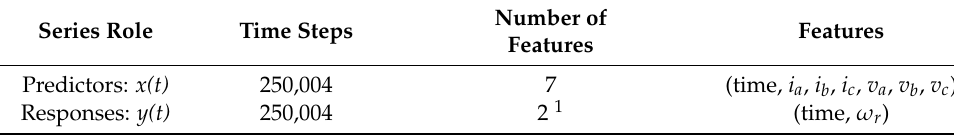
Table 3. Created narx ANN characteristics.